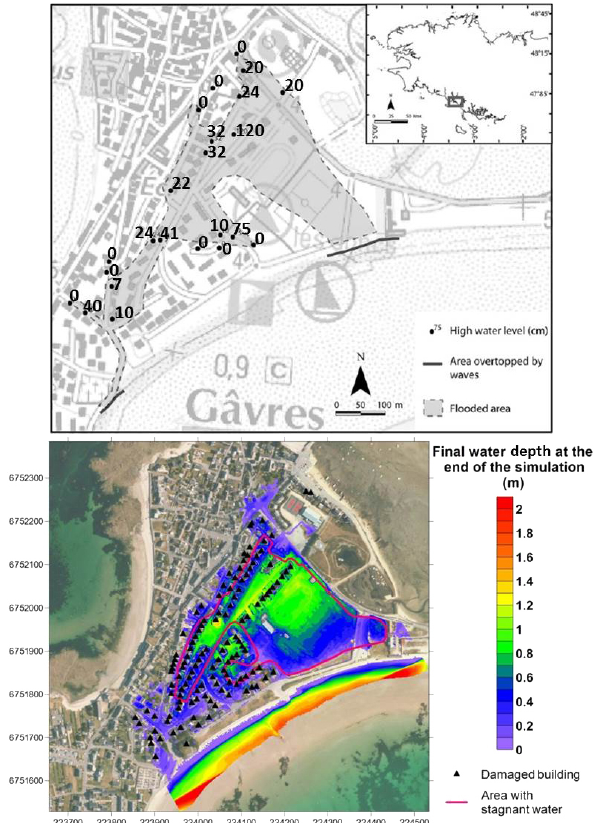
Figure 10. Above: measurements of maximum water depths (mod- ified from Cariolet, 2010); below: final water depth at the end of the SURF-WB simulation and reported flooded buildings and stagna- tion area according to the municipality (from the Gâvres municipal- ity and Le Cornec and Peeters,